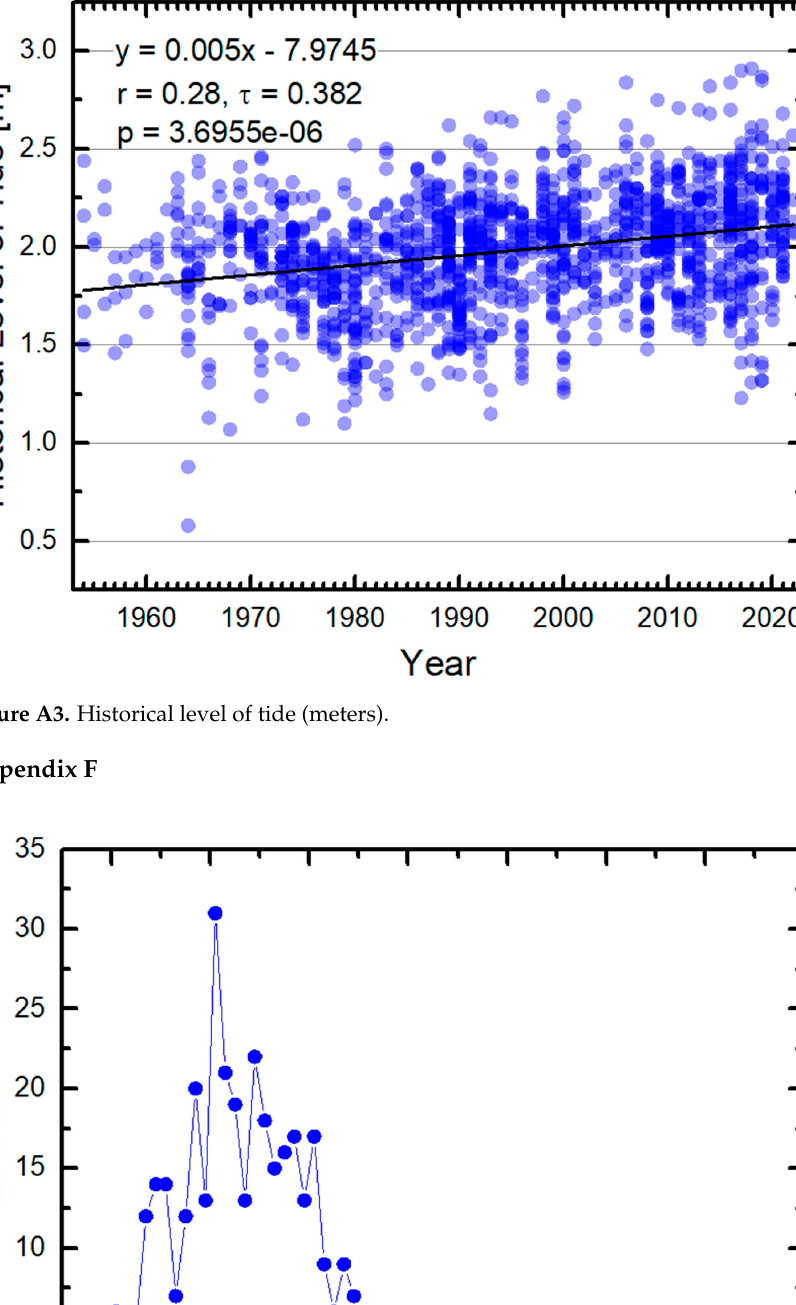
Figure A2. Distribution of constructed and green infrastructures.